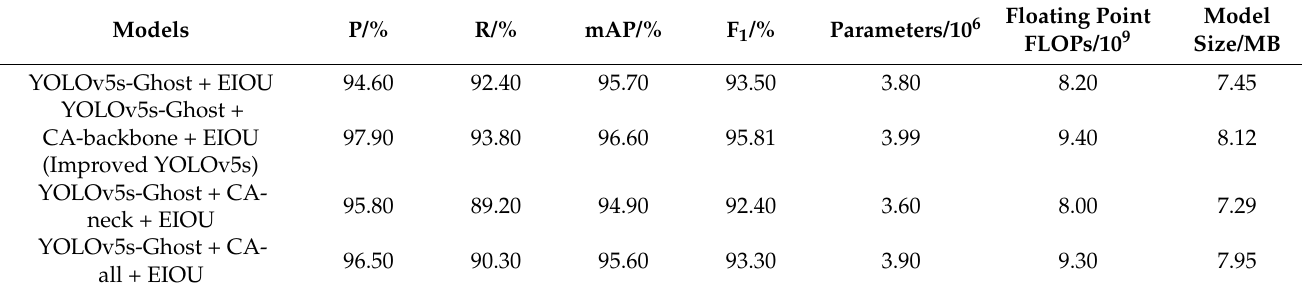
Table 2. Comparison of CA module fusion results.